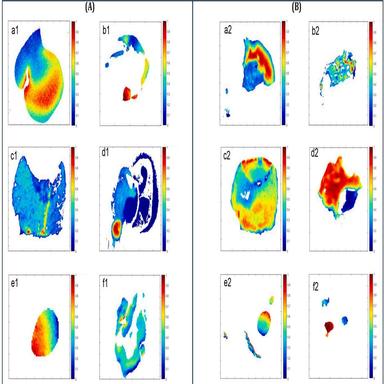
Distribution maps of inclusions acquired by MCR-ALS. (A): at ambient temperature (a1-f1), (B): after melting process (a2-f2). The color distribution in these figures represents the NMI concentration, aiding in the visualization of the NMI distribution patterns and their variations across different conditions, with red indicating high concentration and blue indicating low concentration. (For interpretation of the references to color in this figure legend, the reader is referred to the web version of this art